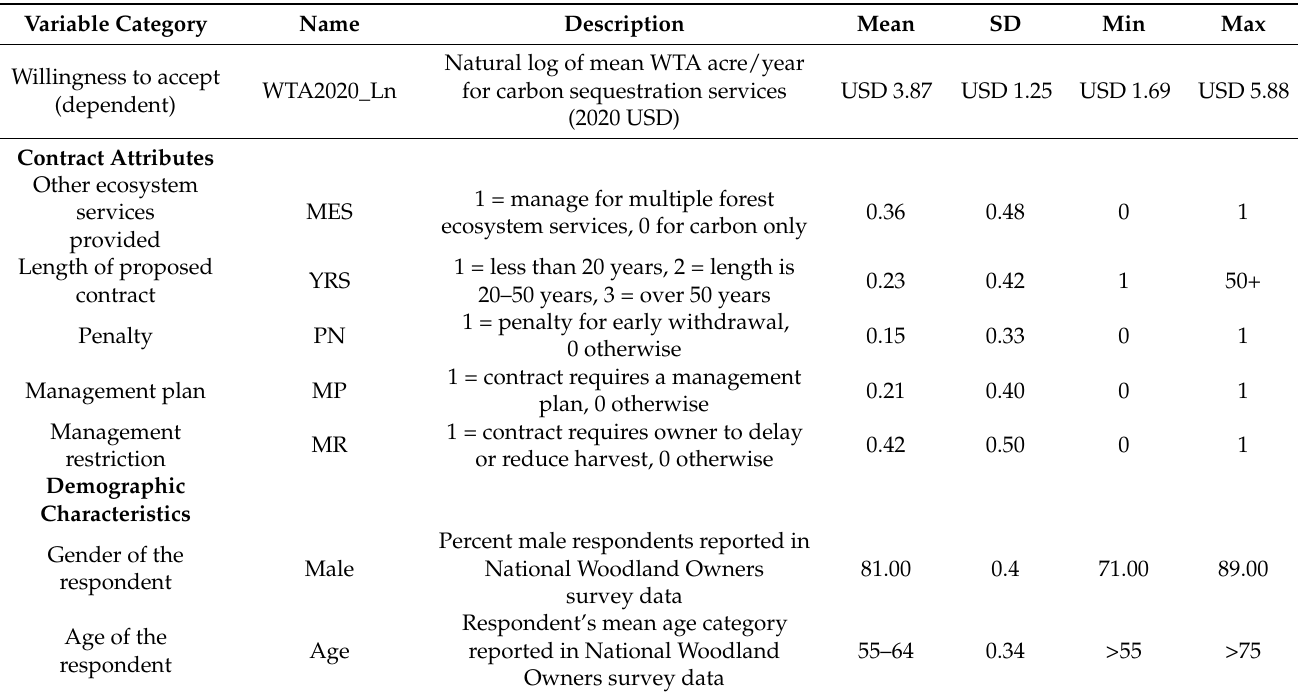
Table 2. Description of the variables tested in the regression